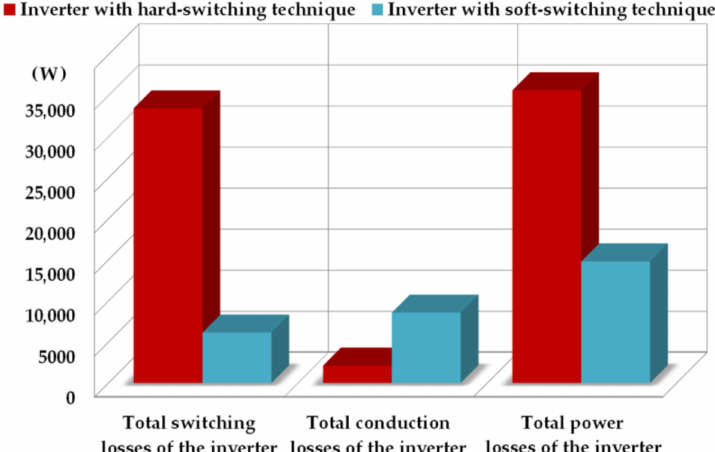
Figure 17. Comparison of the switching losses, conduction losses, and total power losses; switching frequency: 7.68 kHz, k max = 2.25.